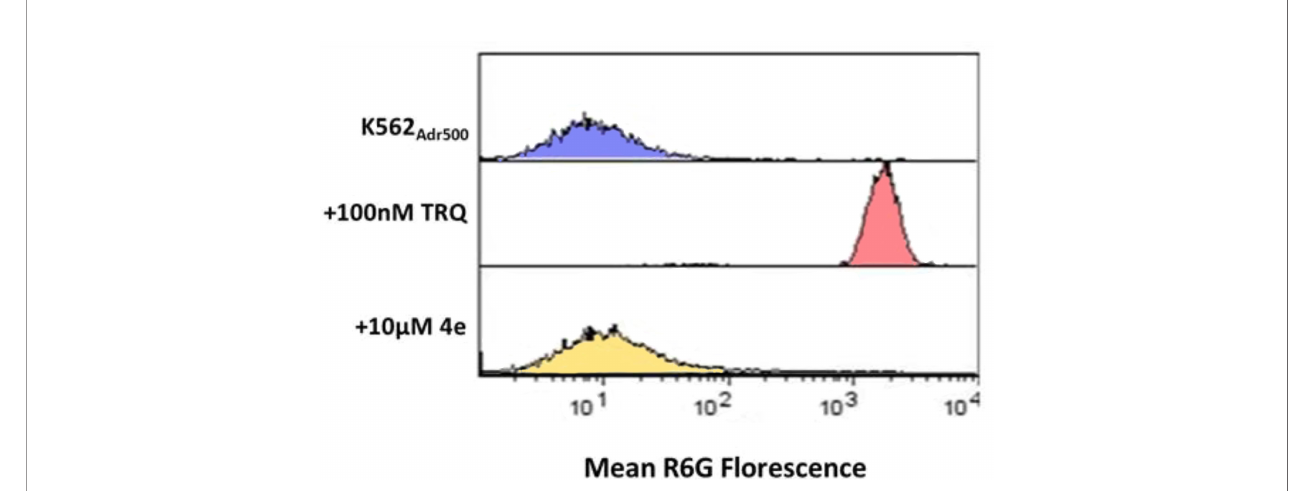
FIGURE 6 | Effect of 4e on R6G retention in K562Adr500 cells. The ABCB1 ef fl ux activity was assessed by measuring the percentage of R6G retention in K562Adr500 cells by fl ow cytometry with tariquidar as the positive